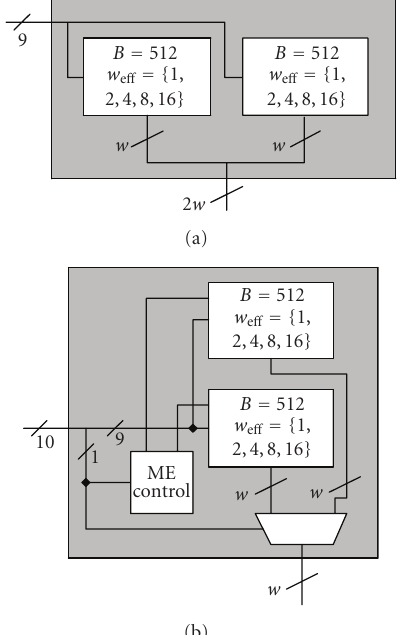
Figure 15: Forming logical memories: (a) area e ffi cient and (b) power e ffi